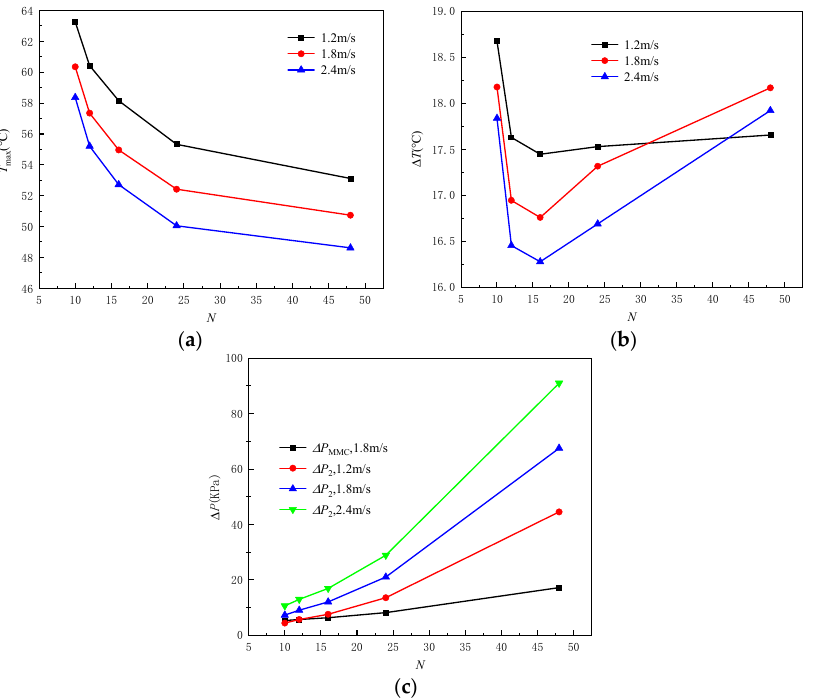
Figure 16. Heat transfer performance of the MDMC at different microchannels number. ( a ) T max ; ( b ) Δ T ; ( c ) Δ P .